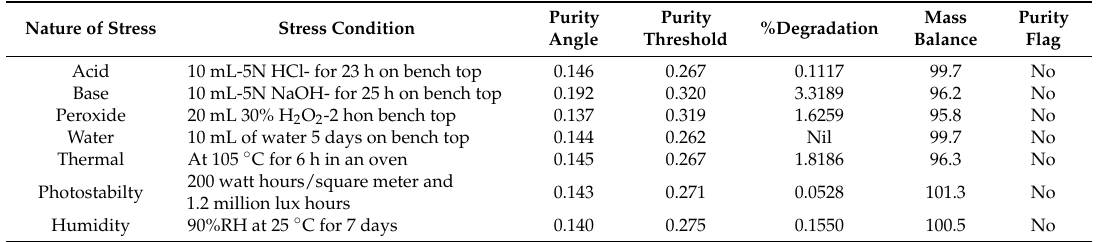
Table 2. Purity Angle, Purity Threshold, %Degradation, Mass Balance, and Purity Flag obtained for each stress